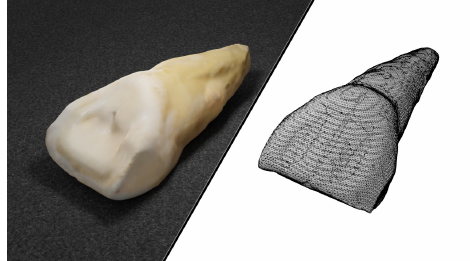
Figure 8. Textured for 3D model of VII-7-2-2.1 tooth.